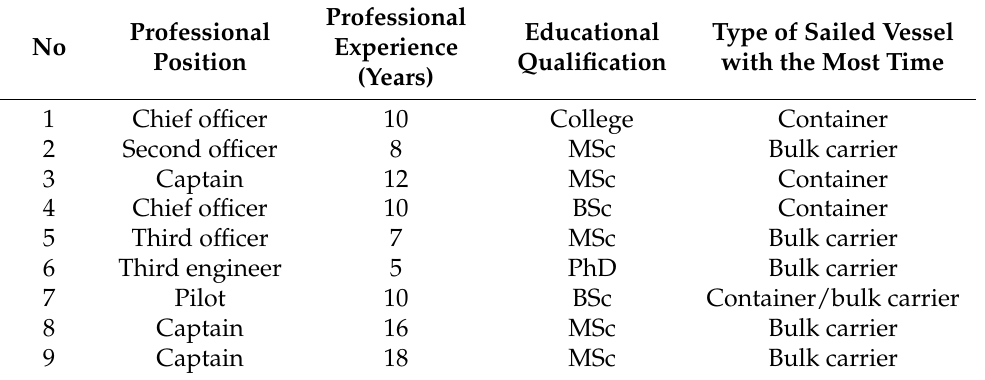
Table 6. Profiles of interviewed seafarers.